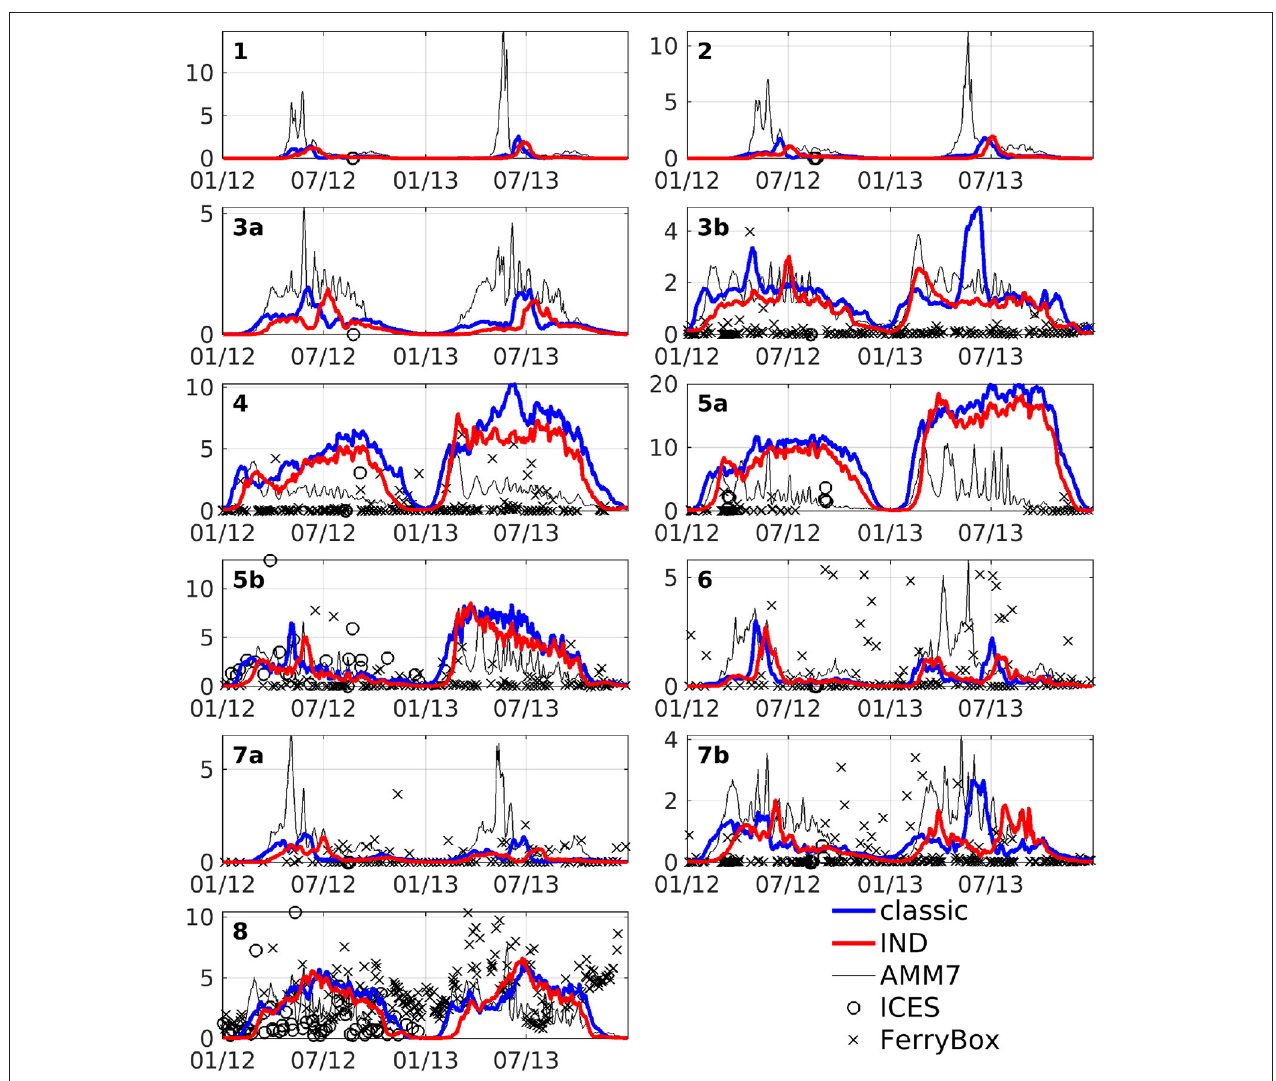
FIGURE 6 | Area averages of chlorophyll at 3 m depth in units of mg Chl m − 3 . Blue line is the classic scheme, red is the IND scheme, black is AMM7, black crosses is FerryBox data and black circles is ICES bottle